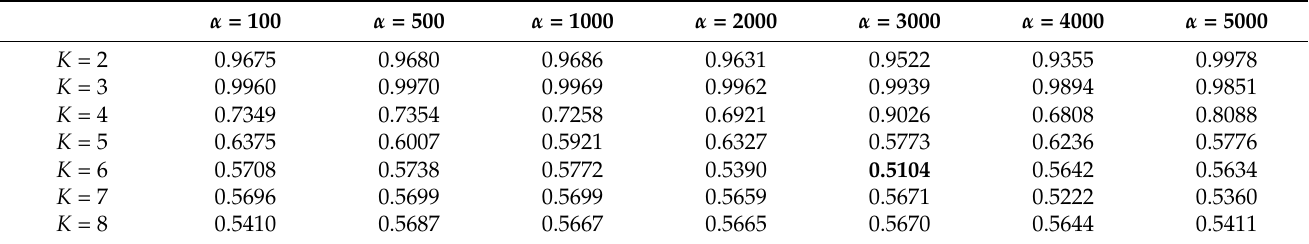
Table 1. WPE values for different K and α for VMD decomposition of GEFCom